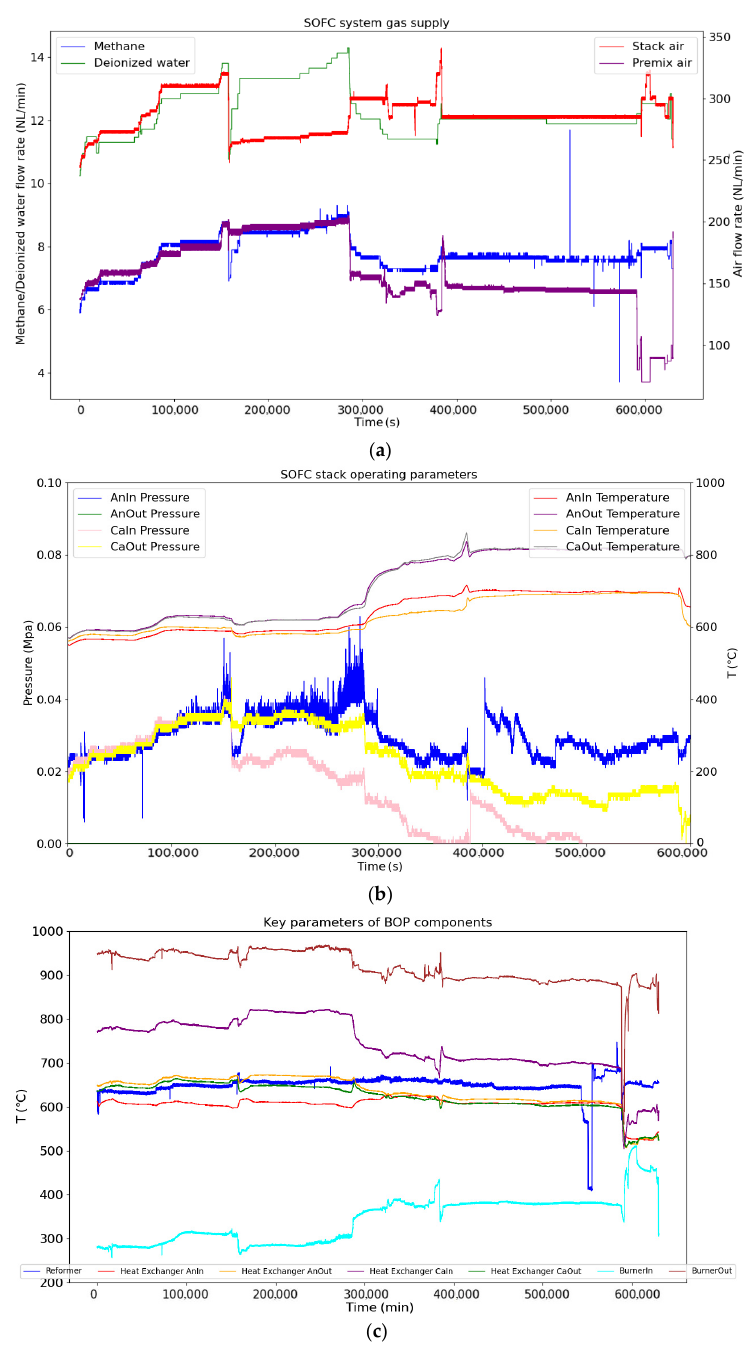
Figure 4. Experimental response curve of the SOFC system in full working condition. ( a ) SOFC system gas-supply curve; ( b ) SOFC stack operating parameter curve; ( c ) BOP component parameter variation curves.